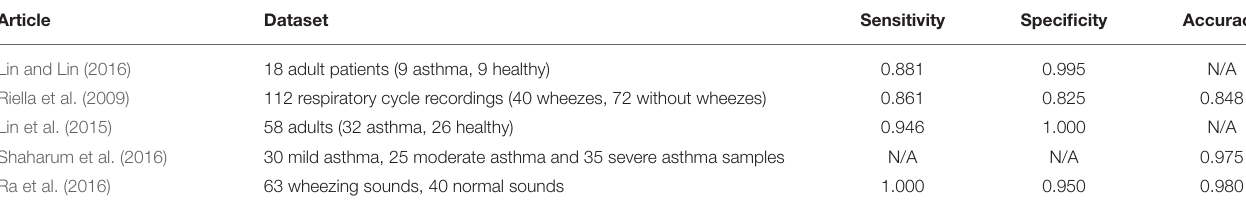
TABLE 1 | Comparison of datasets used in other papers with best classification results reported (if